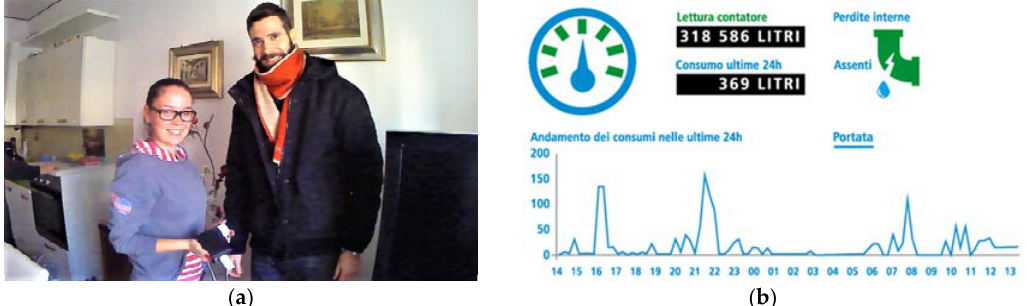
Figure 3. ( a ) Installation of a data collector in a user’s house of Gorino Ferrarese; ( b ) Screenshot of the Rilheva platform that allows the visualization of the processed data to the